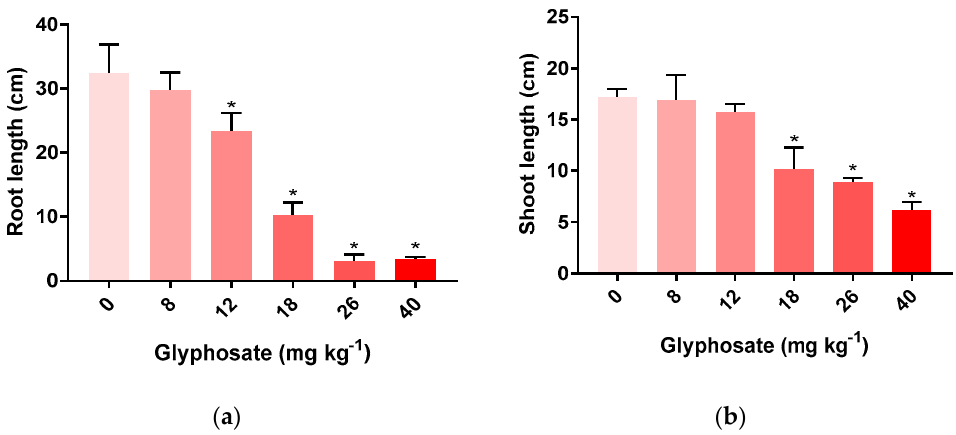
Figure 1. Average root ( a ) and shoot ( b ) lengths of M. sativa plants, 21 days after exposure to different concentrations of glyphosate (GLY). Error bars correspond to the standard deviation. Statistically significant differences compared to the control (CTL; no GLY), considering p ≤ 0.05, are marked with a * above bars.